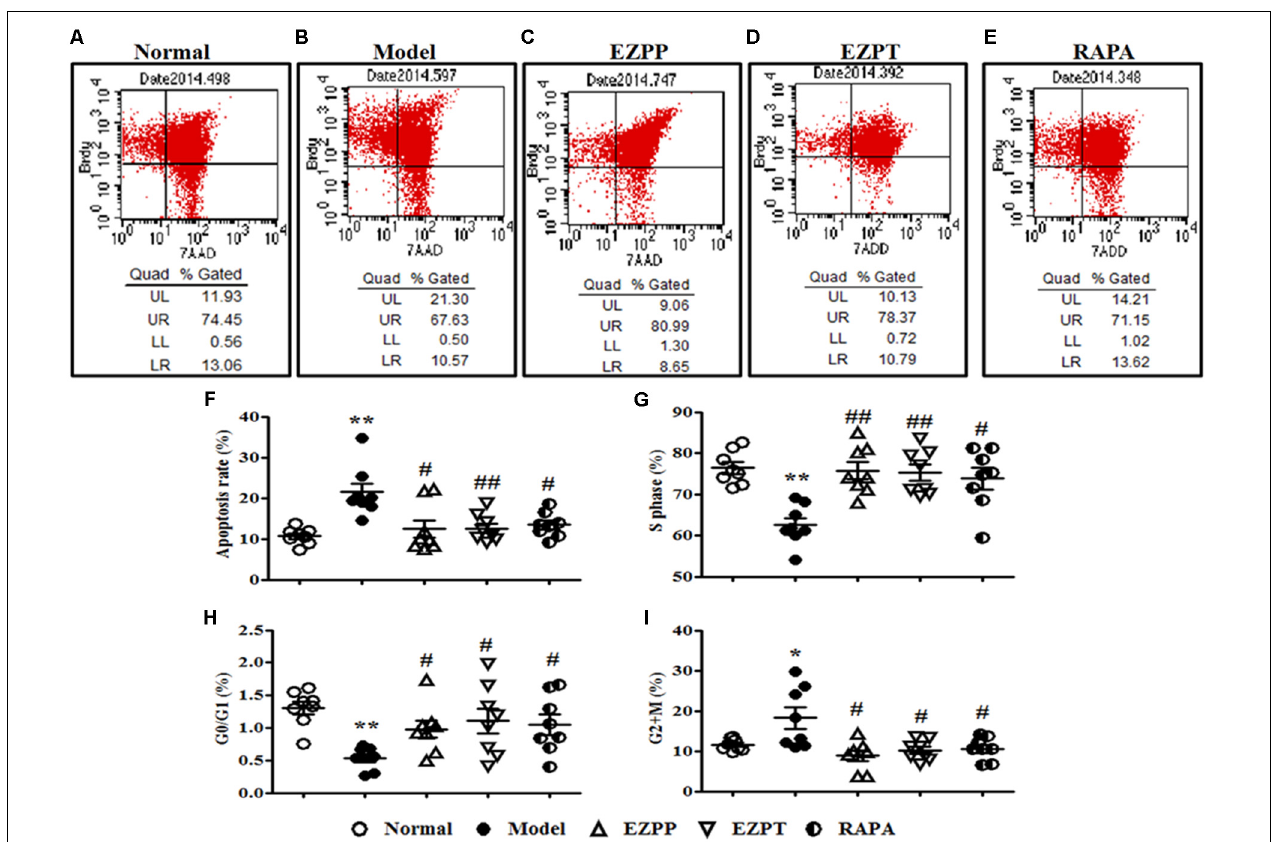
FIGURE 4 | BrdU staining in hepatocytes from rats with liver injury induced by 2AAF/PH. Cellular incorporation of BrdU staining can be detected by flow cytometry to analyze apoptosis and proliferation in vivo . BrdU in hepatocyte of rats induced by 2AAF/PHx was labeled by intraperitoneal injection of BrdU, and measured by flow cytometry and staining with anti-BrdU antibody and 7-AAD. The representative scatter diagrams of each group are shown: Normal (A) , Model group (B) , EZPP group (C) , EZPT group (D) , and RAPA group (E) . Results were analyzed by Flowjo version 7.6.1 software, which included apoptosis (F) , and number of cells in S phase (G) , G0/G1 phase (H) and G2+M phase (I) . Data are expressed as mean ± SEM ( n = 8). ∗ p < 0.05 and ∗∗ p < 0.01 versus Normal group; # p < 0.05 and ## p < 0.01 versus Model